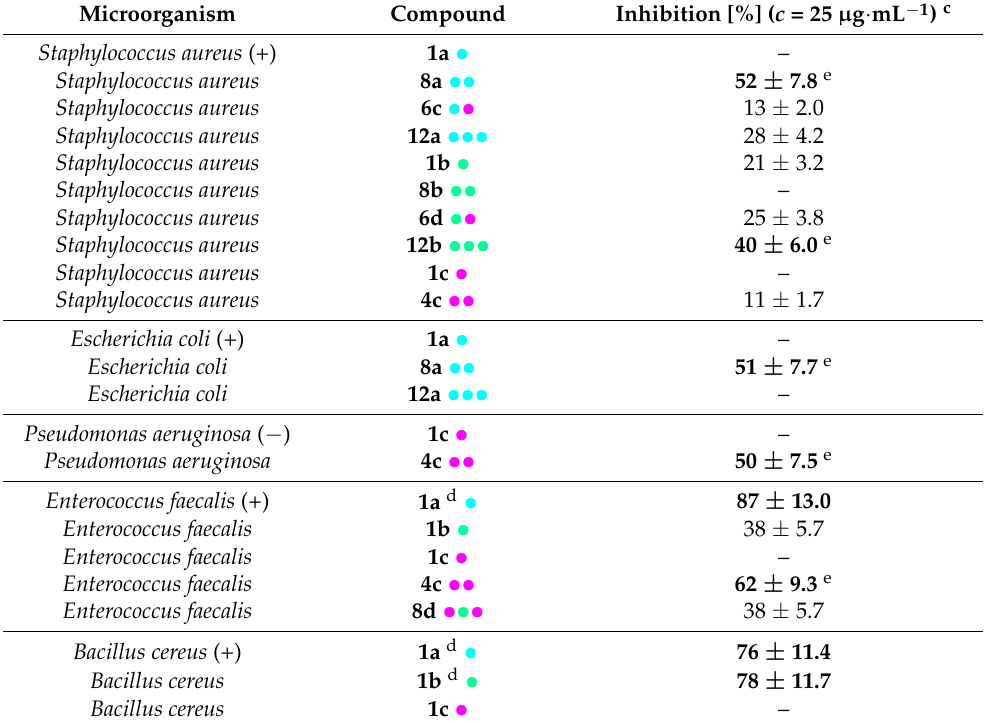
Table 1. Selected data of the antimicrobial activity a,b .